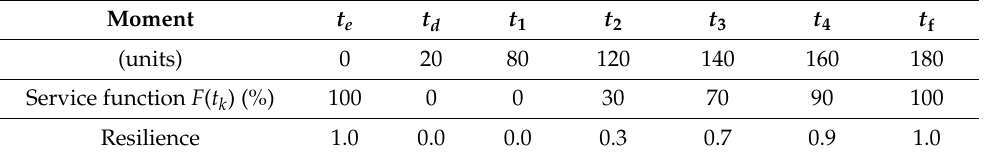
Table 1. Simulation of a Possible Security Breach—Location 1.